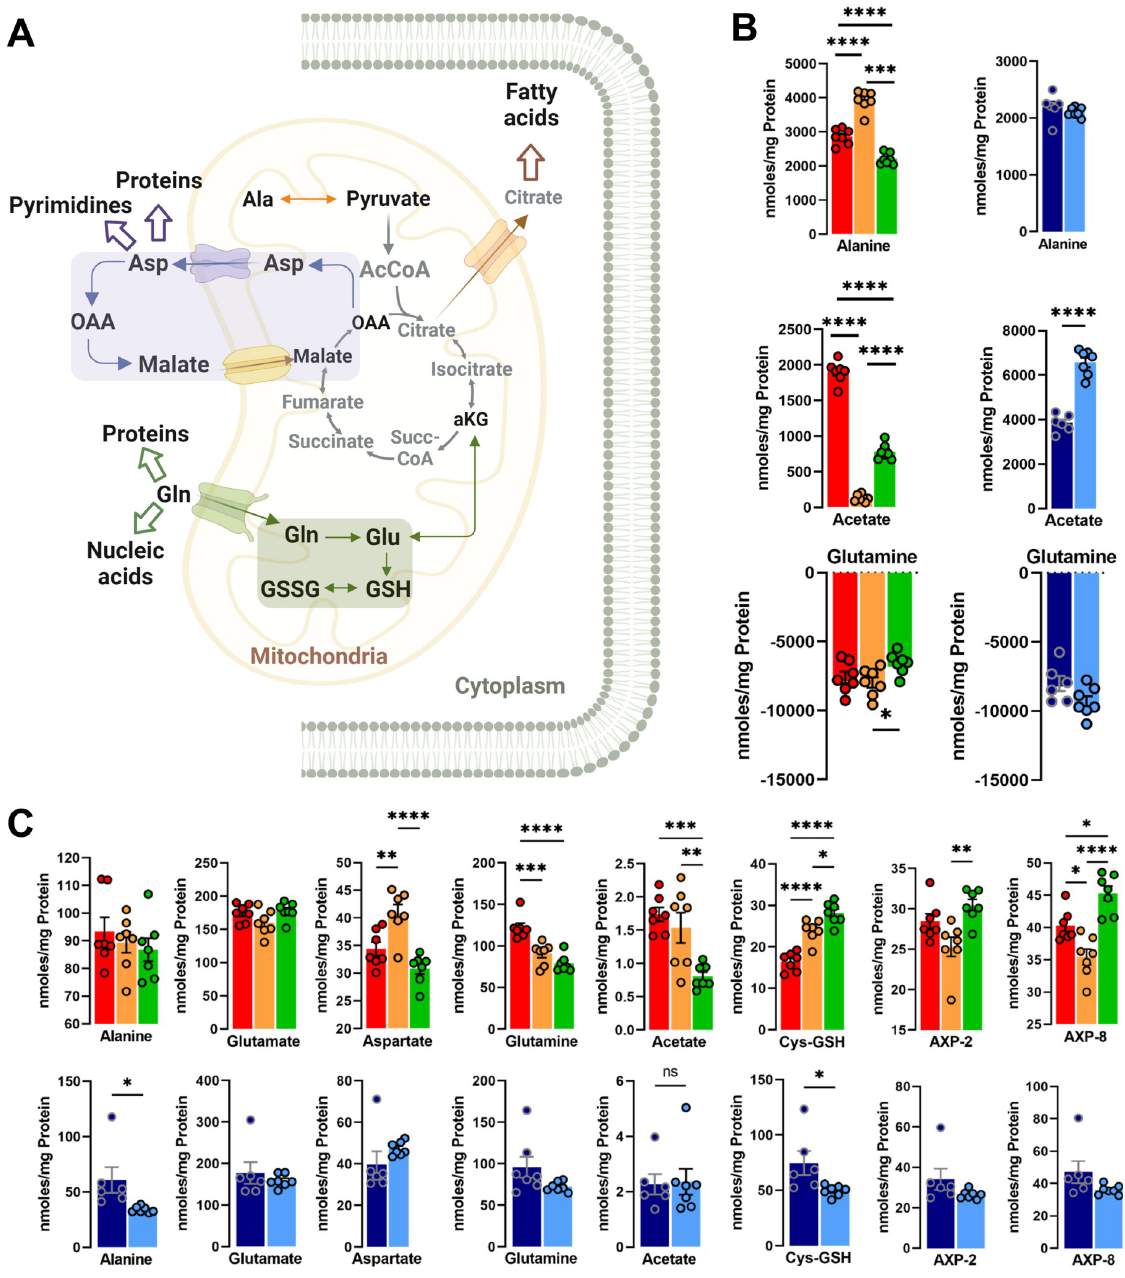
Fig 2. Anabolic and anaplerotic pathway modulation by the RON-DEK- β -catenin axis. ( A ) Schematic of TCA cycle and associated anabolic pathways (created with BioRender.com) illustrating the trends of R7 (red), R7sgRON (orange), R7shDEK (green), MRBC FL (dark blue), and MRBC KO cell lines (light blue). ( B ) Extracellular metabolites expressed as the difference of the metabolite abundance quantified at 24 h and the corresponding amount at t = 0 h. Positive values indicate excreted metabolites, while negative values show consumption of metabolites from the media over time. ( C ) Intracellular metabolites associated with anaplerosis and anabolic pathways including alanine, glutamate (glutamate-4), aspartate (aspartate-3), glutamine, acetate, cysteine-glutathione (Cys-GSH), adenosine mono-/di-/-triphosphate (AXP). (AXP-8: position 8 of the adenine base, AXP-1’: position 1 of the ribose) and uridine mono-/di-/-triphosphate (UXP), (UXP-1’: position 1 of the ribose). Bar graphs indicate mean and error bars represent SEM of replicates. Replicates of each cell line are shown as individual dots (n = 6–7). Statistical significance was assessed using one-way ANOVA and two-tailed Student’s t-test for R7 and MRBC comparisons, respectively. � P � 0.05; �� P � 0.01; ��� P � 0.001; ���� P � 0.0001.